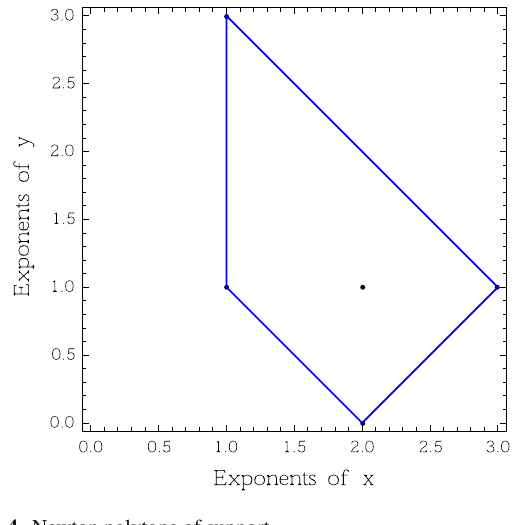
Fig. 4 Newton polytope of